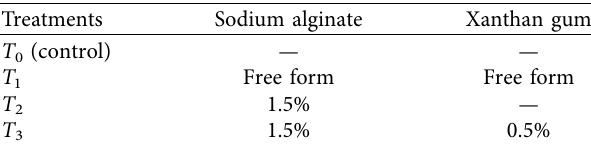
Table 1: Treatment plan for encapsulation of Lactobacillus rhamnosus